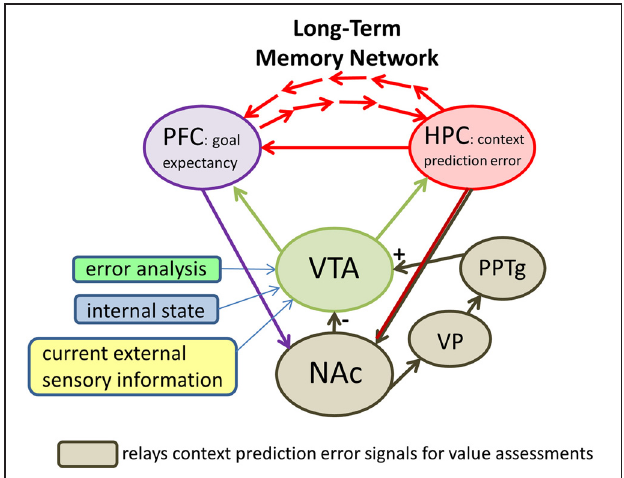
FIGURE 3 | A proposed neural circuit illustrating that midbrain (dopamine) systems and the prefrontal cortex (PFC) are key brain areas that evaluate the significance of hippocampal (HPC) context prediction error signals for the purpose of directing future behaviors and updating long-term memories. Direct HPC output arrives in the midbrain system via projections to the ventral striatum (i.e., the nucleus accumbens, or NAc). The NAc determines whether the outcomes of behavior are as predicted based on an animal’s expectations for a given context. If the outcome is as expected, NAc continues exerting inhibitory control ( − ) over ventral tegmental area (VTA) neurons. In this case, encounters with rewards do not result in dopamine cell firing. In constrast, context prediction error signals from the HPC to the NAc may preferentially excite ( + ) VTA neurons via an indirect pathway that includes the ventral pallidum (VP) and the pedunculopontine nucleus (PPTg). The result of this elevated excitation may be a depolarization of VTA neurons such that they are more likely to fire when subsequent reward information arrives in VTA. Also influencing the likelihood that dopamine cells will fire in response to future rewards are specific computations that reflect negative reward prediction errors (reward prediction error analysis), information about the animal’s current motivational and behavioral state (internal state), and additional information about the current salient cues (current external sensory information). The latter appears to involve at least the PPTg. The impact of the prefrontal cortex on VTA function is not clear. One possibility is that it provides the midbrain circuitry with information about what to expect in terms of goals based on past experience. The summed input to the VTA results in an output that reflects the subjective value of context prediction error